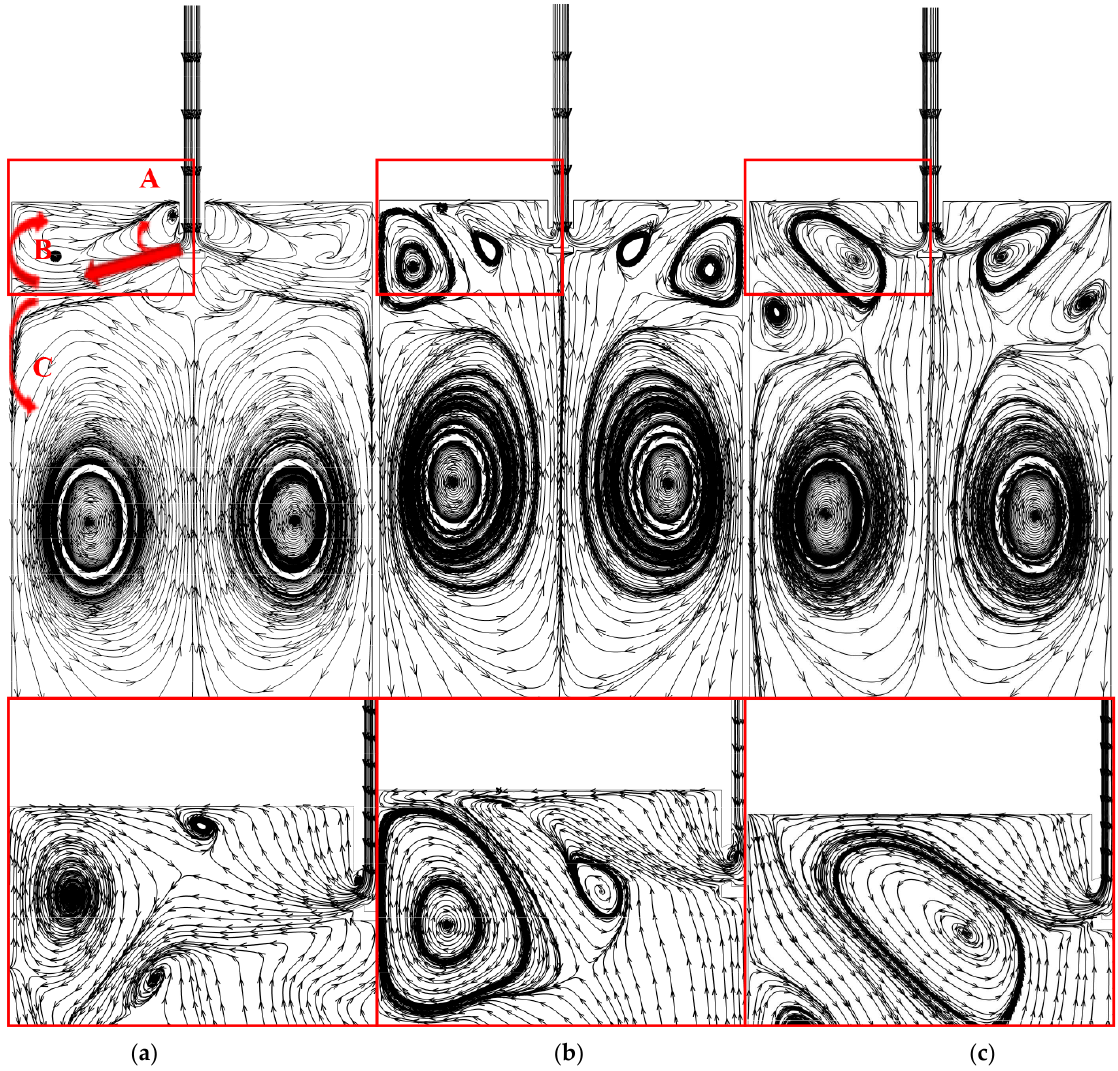
Figure 4. Streamlines on the center plane of mold at the different argon gas flow rates of ( a ) 6 L/min, ( b ) 10 L/min, ( c ) 14 L/min, with enlarged views below corresponding to the upper part of the